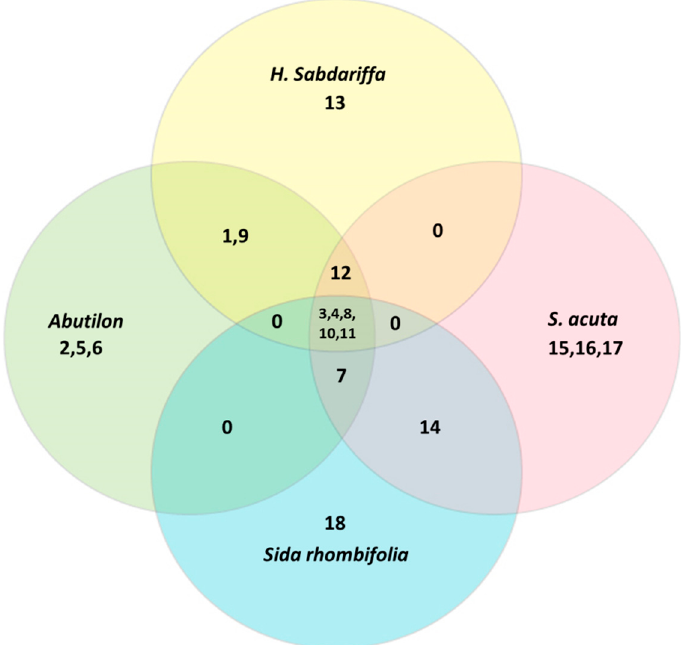
Figure 1. Common and unique classes of major phytoconstituents reported in Abutilon indicum